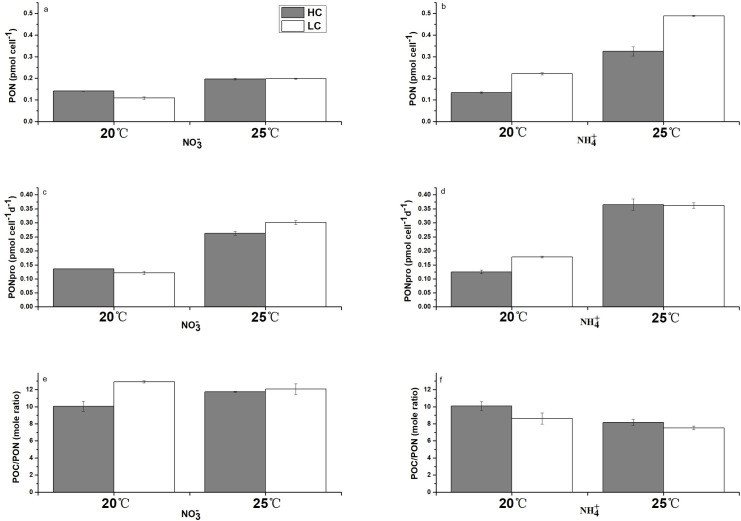
PON (a, b), PON production rate (c, d) and POC/PON (e, f) in NO3— and NH4+-grown cultures under HC (1000 μatm) and LC (400 μatm) at 20°C and 25°C. The values are the means and error bars are standard deviations for triplicate cultures at each treatment (p<0.05).